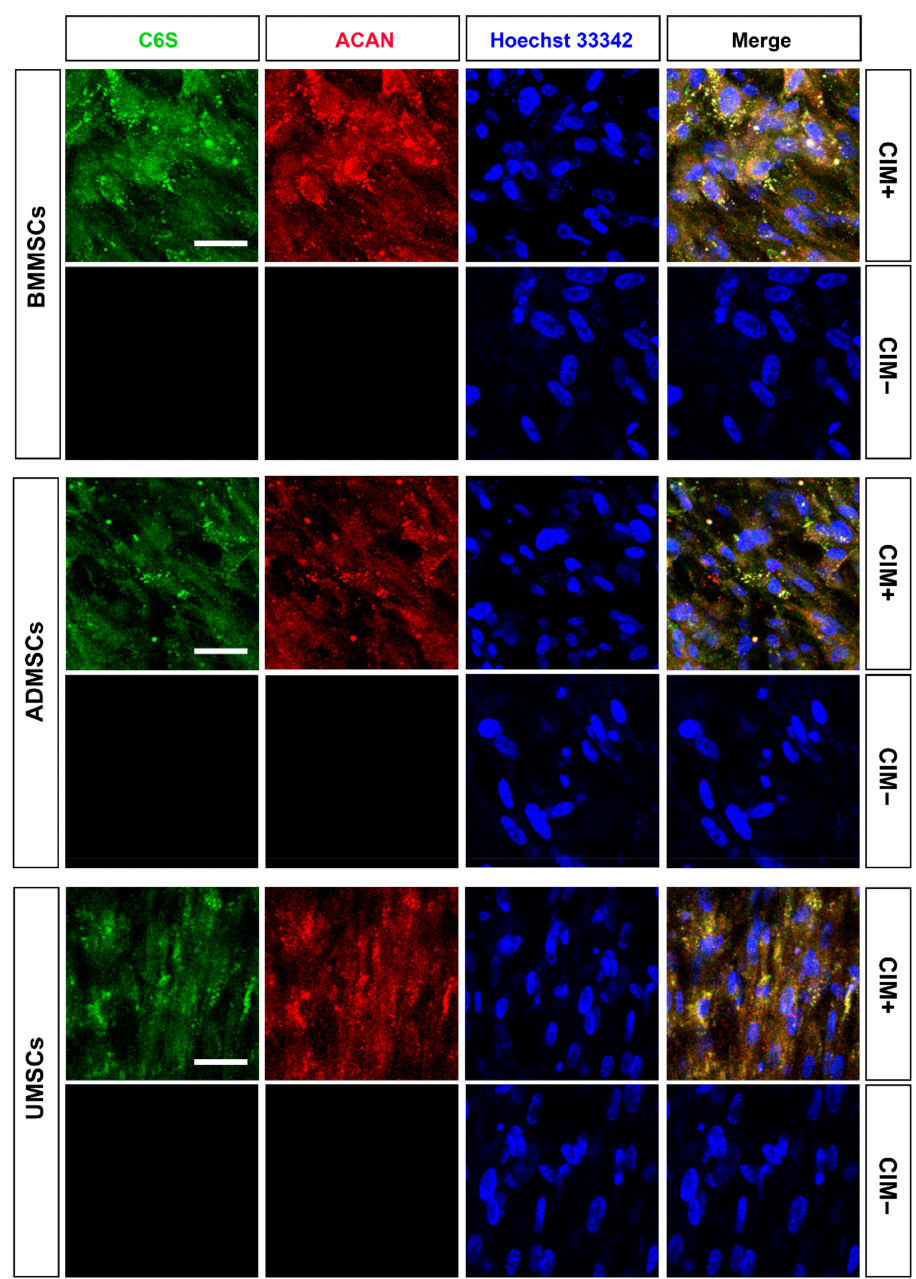
Figure 5. Characterization of chondrogenesis of hMSCs on hDCB blocks. The hMSCs of three origins were seeded onto hDCB blocks, treated with or without chondrogenic differentiation medium for 21 days (CIM+ and CIM − , respectively), stained with chondroitin 6–sulfate (C6S) and aggrecan (ACAN) antibodies to assess chondrogenesis. Green, red, and blue represent C6S, ACAN, and nuclei, respectively. Scale bars are 50 µ